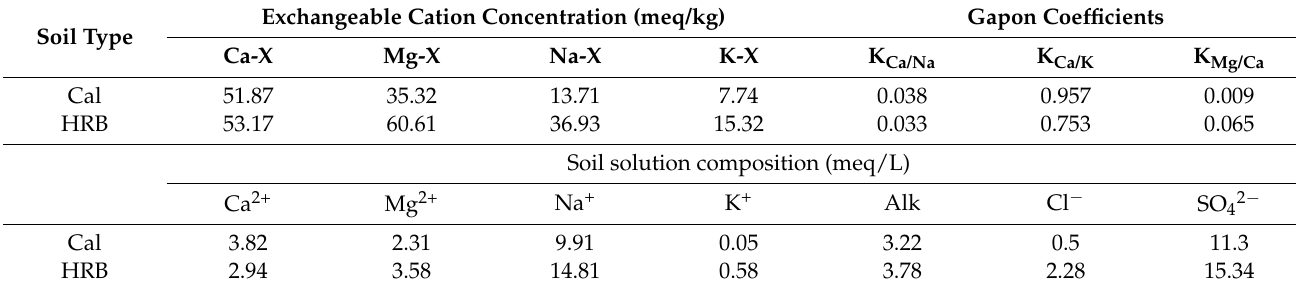
Table A2. The estimated initial concentrations of cations, Gapon selectivity coefficients, and soil solution compositions in different soil